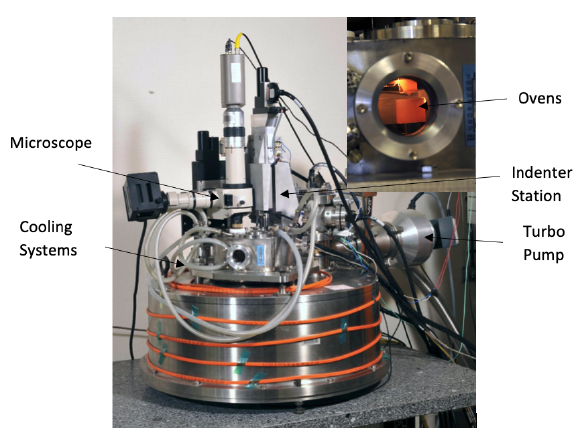
Figure 2. High temperature microhardness